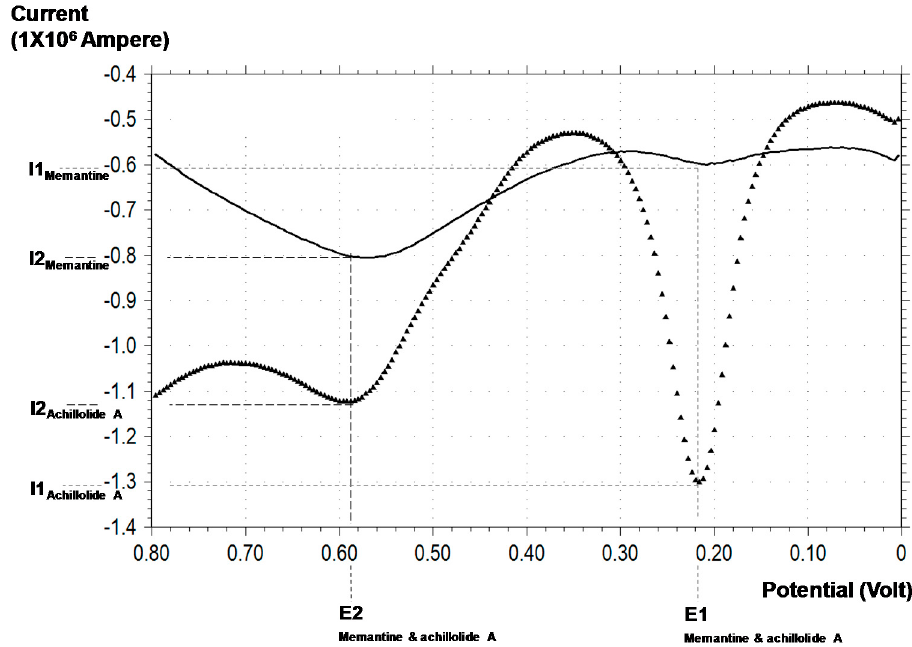
Figure 5. Representative voltammogram of achillolide A and memantine analyses. Representative differential pulse voltammetry (DPV) of aqueous solutions (250 μ M) of achillolide A ( ▲ ) and memantine ( − ) with glassy carbon working electrode, Ag/AgCl reference electrode, and Pt wire as counter electrode. E1-First anodic potential, E2-Second anodic potential, I1-First anodic current, and I2-second anodic current.